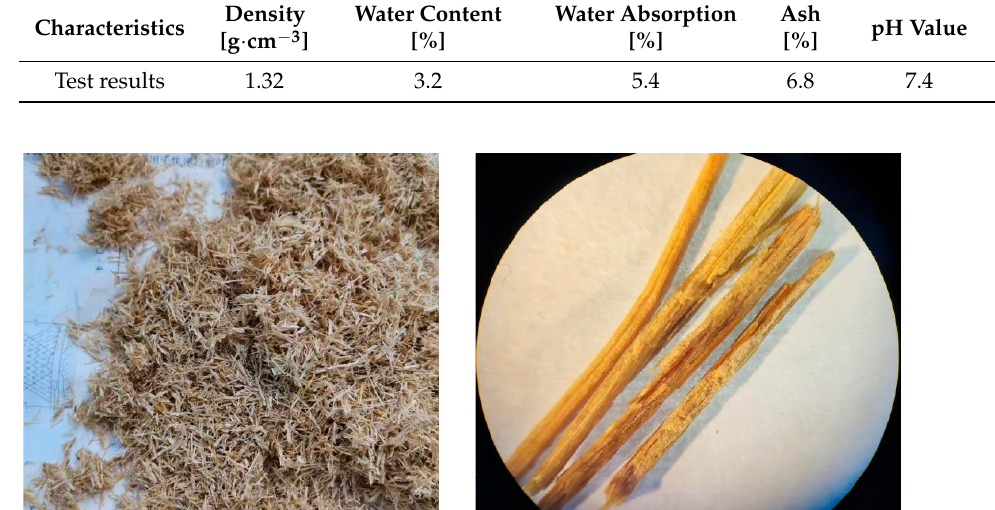
Figure 1. Corn straw